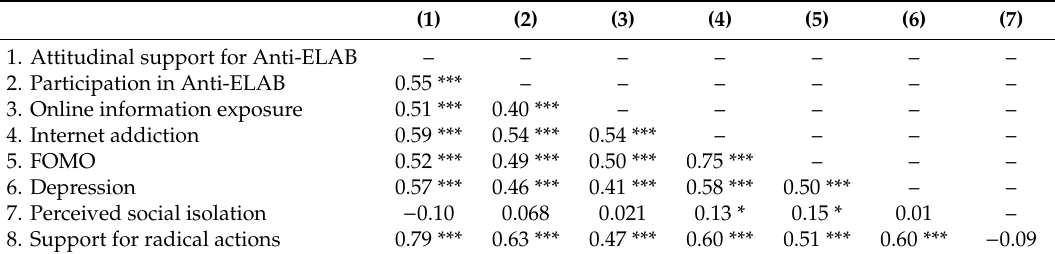
Table 1. Correlations of key variables.